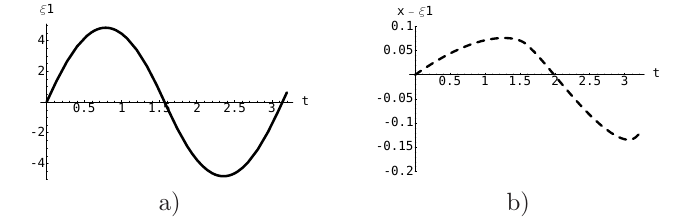
Figure 6. 1 -type solution of the problem